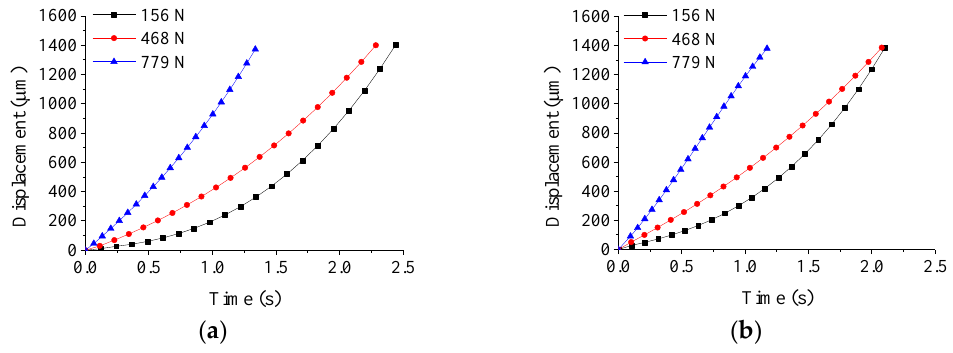
Figure 6. The upper mold displacement w during compression test under different pressing forces at the following molding temperatures: ( a ) 382 °C and ( b ) 392